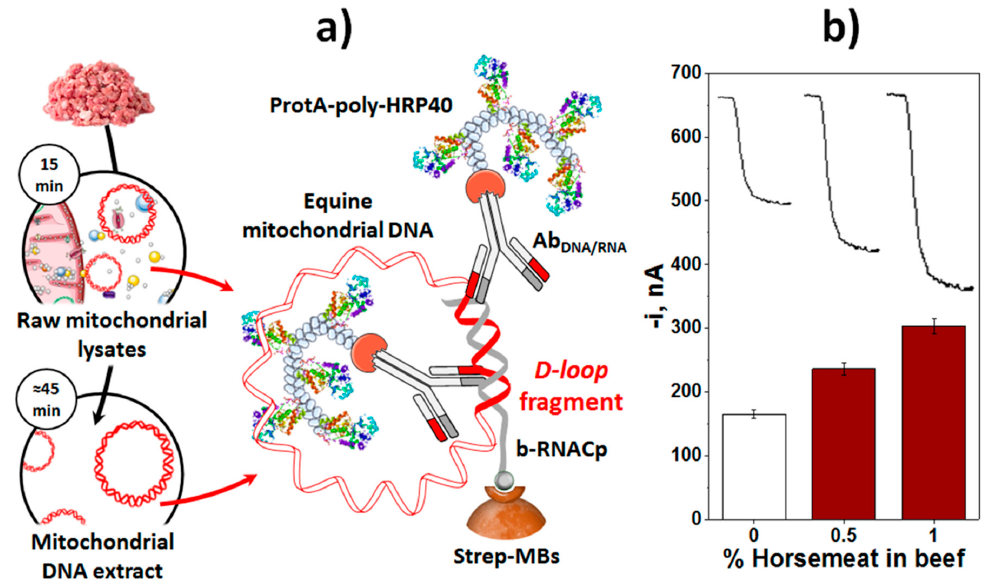
Figure 7. ( a ) Schematic display of the fundamentals involved in the amperometric MBs-based biosensor developed for the detection of horse mtDNA. ( b ) Amperometric traces recorded for 1:1 diluted raw mitochondrial lysates obtained from 3.0 g of mixtures prepared with beef and di ff erent percentages of horse meats. Figure drawn based on